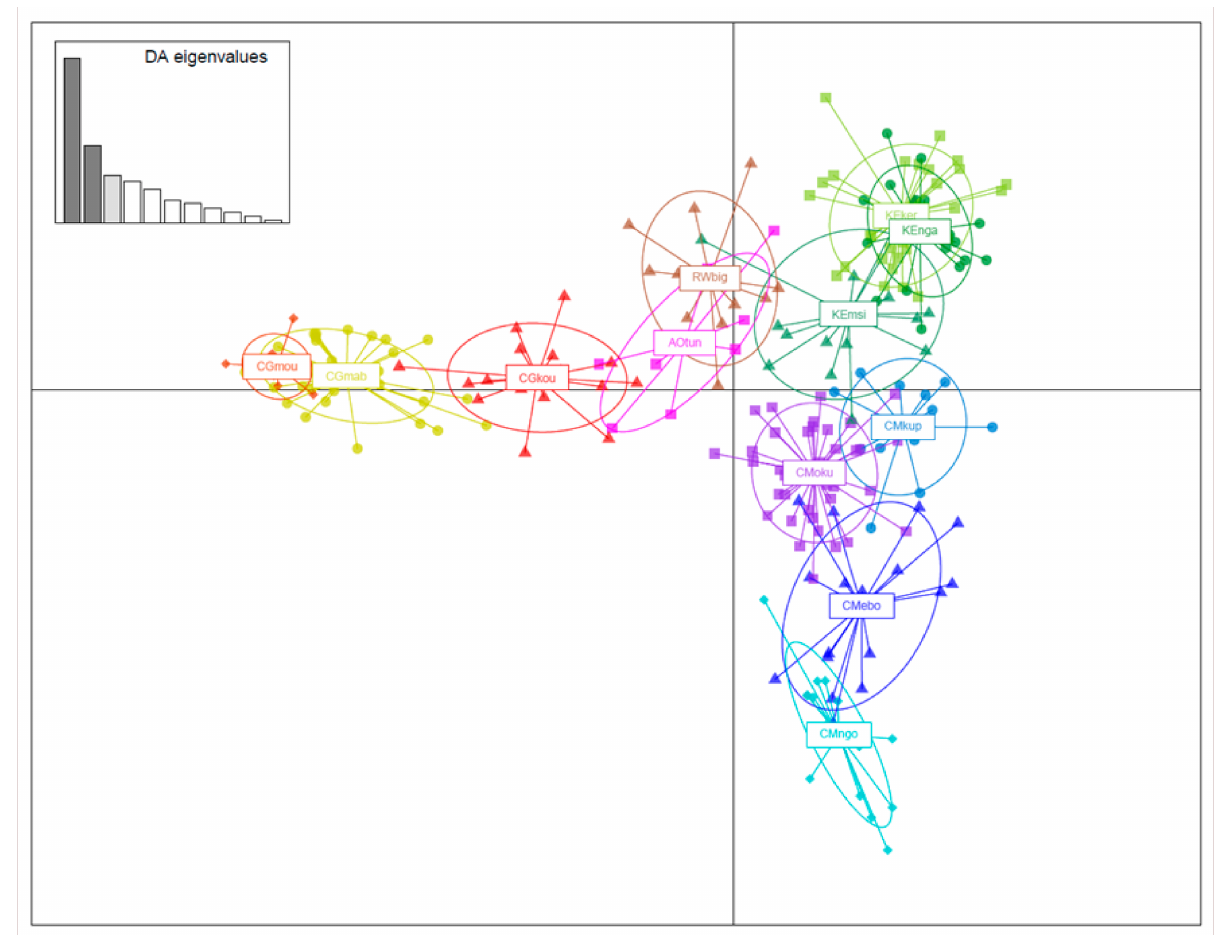
Figure 4. Discriminant Analysis of Principal Components (DAPC) including 229 samples of P. latifolius from western Central Africa and East Africa using nine nuclear SSR markers. X and Y axes of the DAPC scatterplots describe the first and second discriminant functions. Barplots of discriminant analysis eigenvalues (top left) display the proportion of genetic information comprised in each consecutive discriminant function. Populations sampled are distinguished by symbols and colors with 95% inertia ellipses and mapped within the distribution range of P. latifolius (Figure